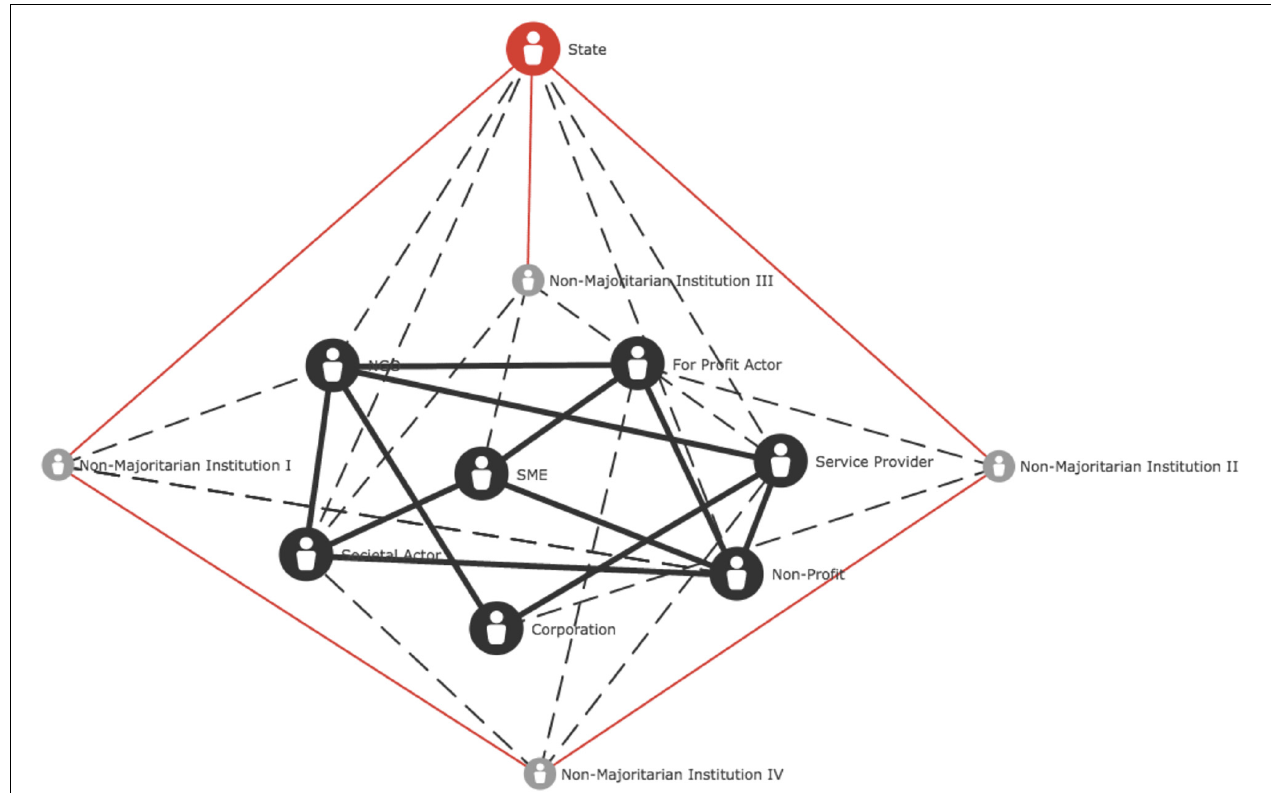
FIGURE 2 | Horizontal policy-making in which societal actors have greater independence in commanding their spheres of influence and/or making and implementing policies. Coinciding with this, the state takes on a role of “steering” rather than “rowing.” The state regulates societal actors by incorporating them into the policy-making process. The role they can play therefore becomes the relevant aspect of power, and the power relationships become the relevant focus of governance. Oversight is performed by non-majoritarian institutions such as central banks that guard the boundaries set by the state.